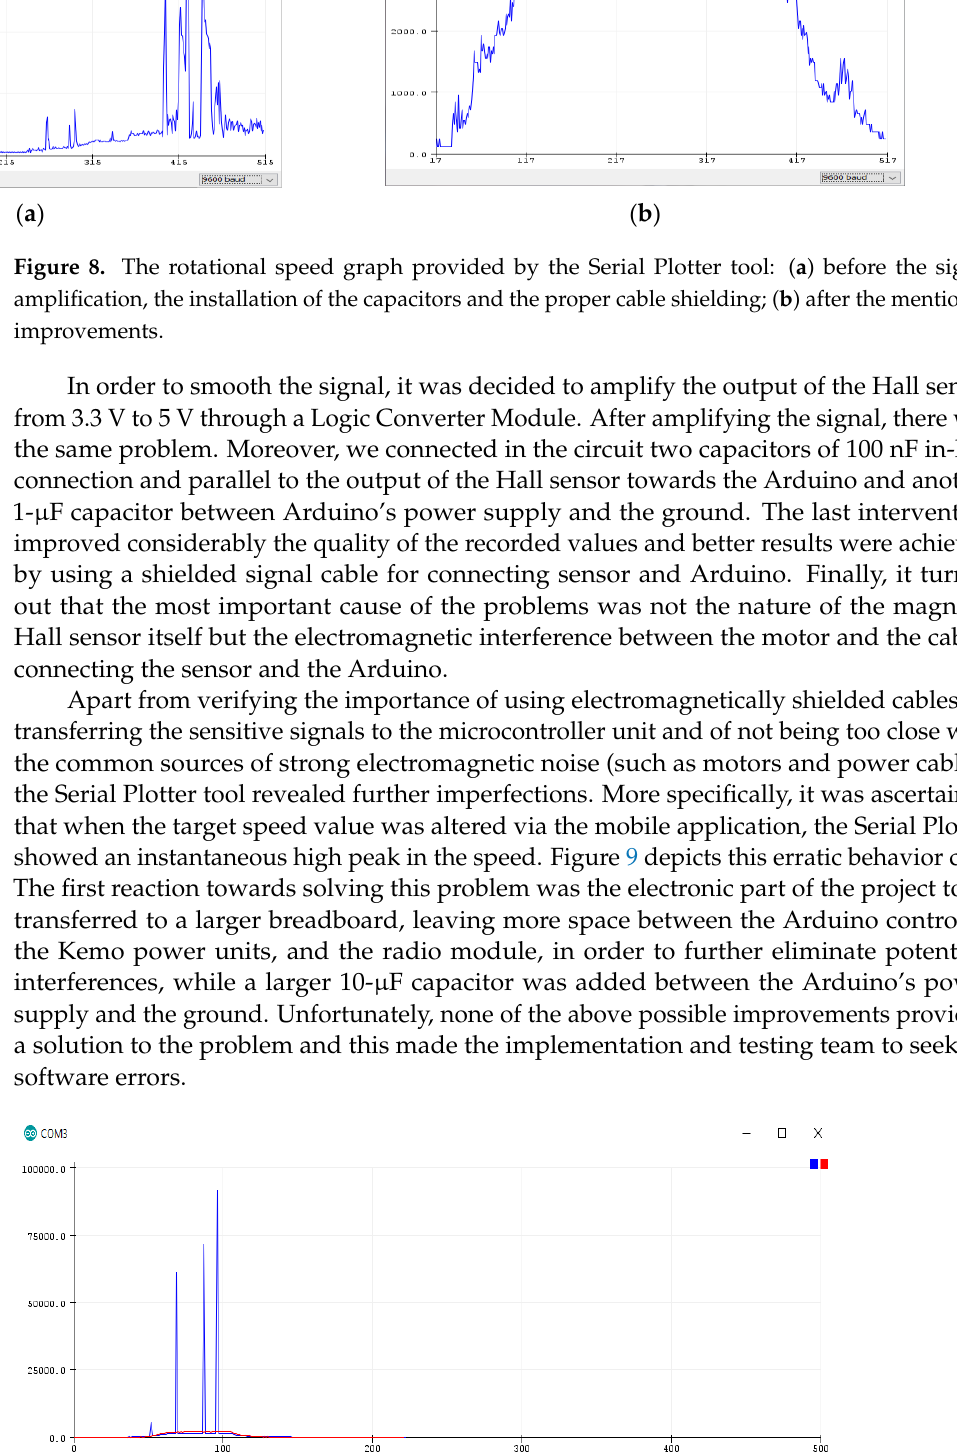
( b ) Figure 7. The oscilloscope’s display: ( a ) before the installation of the Zener diode; ( b ) after the in- stallation of the Zener diode.